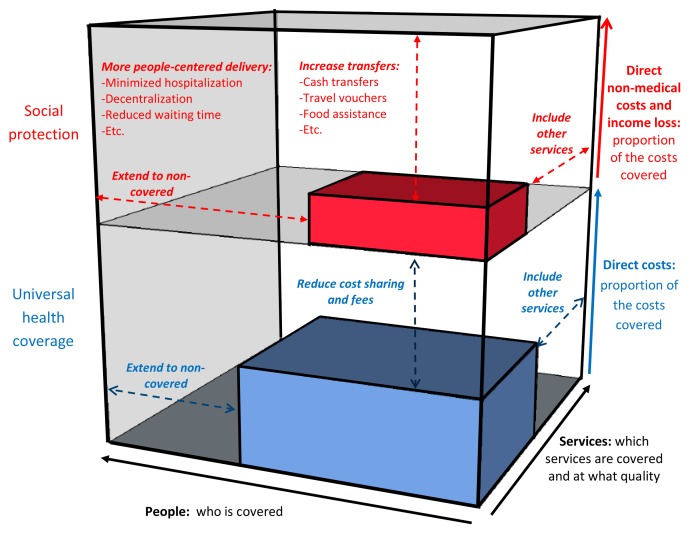
The three dimensions of universal health coverage, with the added dimension of financial risk protection against non-medical costs.Adapted from World Health Report 2010 [21]. Elements in red are non-medical costs and additional interventions within health care and beyond to provide financial protection.